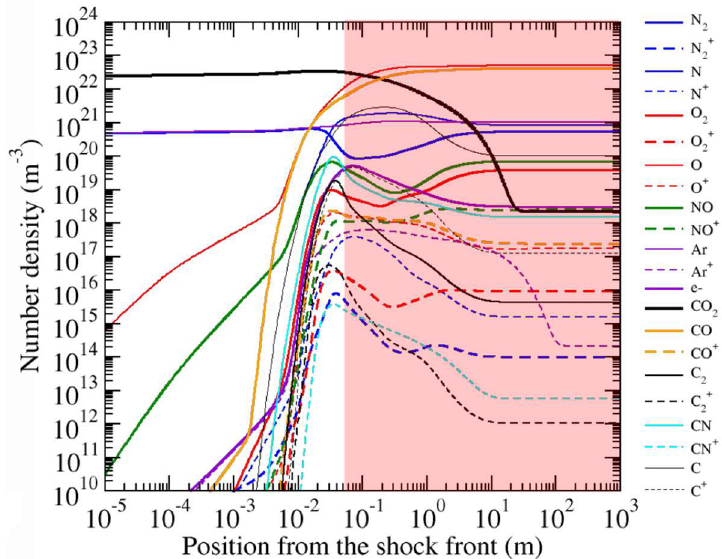
Figure 4. Distribution of the number density of the different species taken into account in the chemistry (see Table 1) behind the shock front. Same as Figure 2: the solution is relevant with respect to the real situation until 5 cm from the shock front.